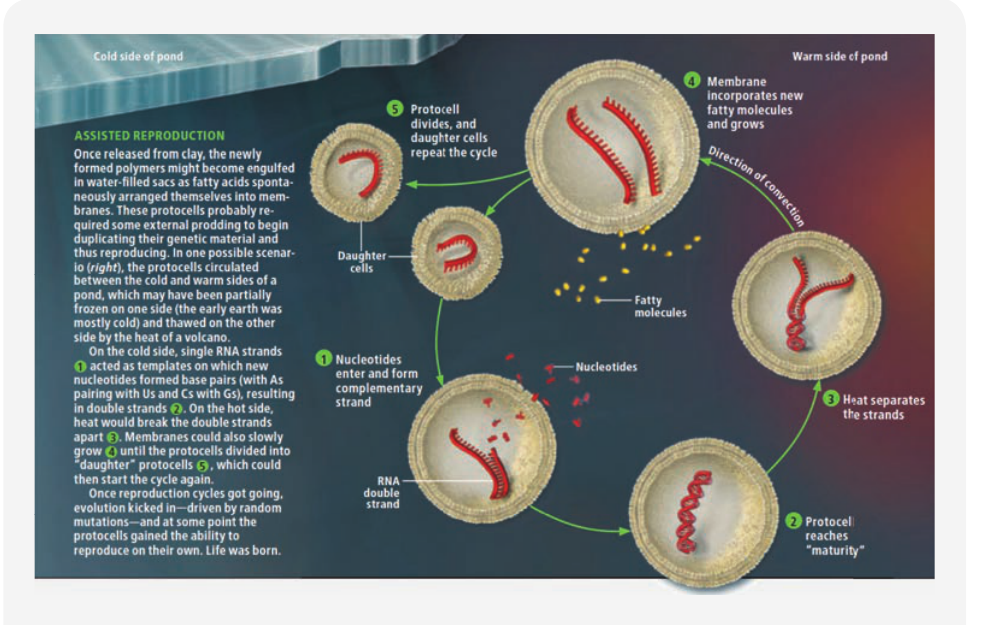
Figure 14. An environmentally driven protocell life cycle. Image from Ricardo and Szostak, Scientifi c American, 2009.